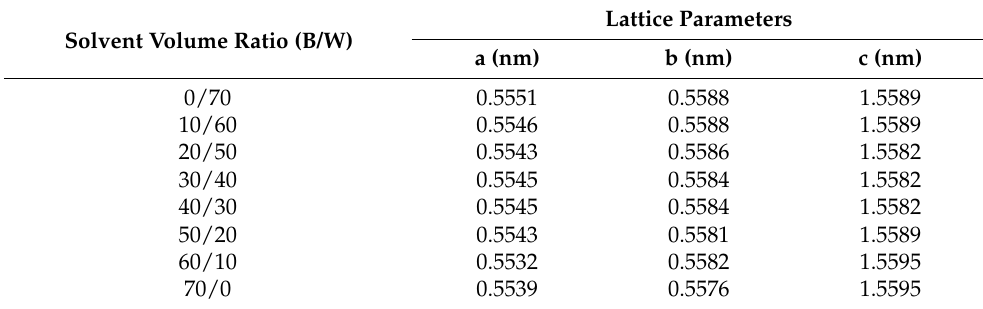
Figure 5. XRD patterns of KNN particles synthesized by glycothermal treatment with various solvent volume ratios of B/W at 200 ◦ C for 12 h: ( a ) 0/70 (pure hydrothermal), ( b ) 10/60, ( c ) 20/50, ( d ) 30/40, ( e ) 40/30, ( f ) 50/20, ( g ) 60/10, and ( h ) 70/0 (pure glycothermal). Table 1. The lattice parameters of KNN particles synthesized by glycothermal treatment with various solvent volume ratios of B/W at 200 ◦ C for 12 h.